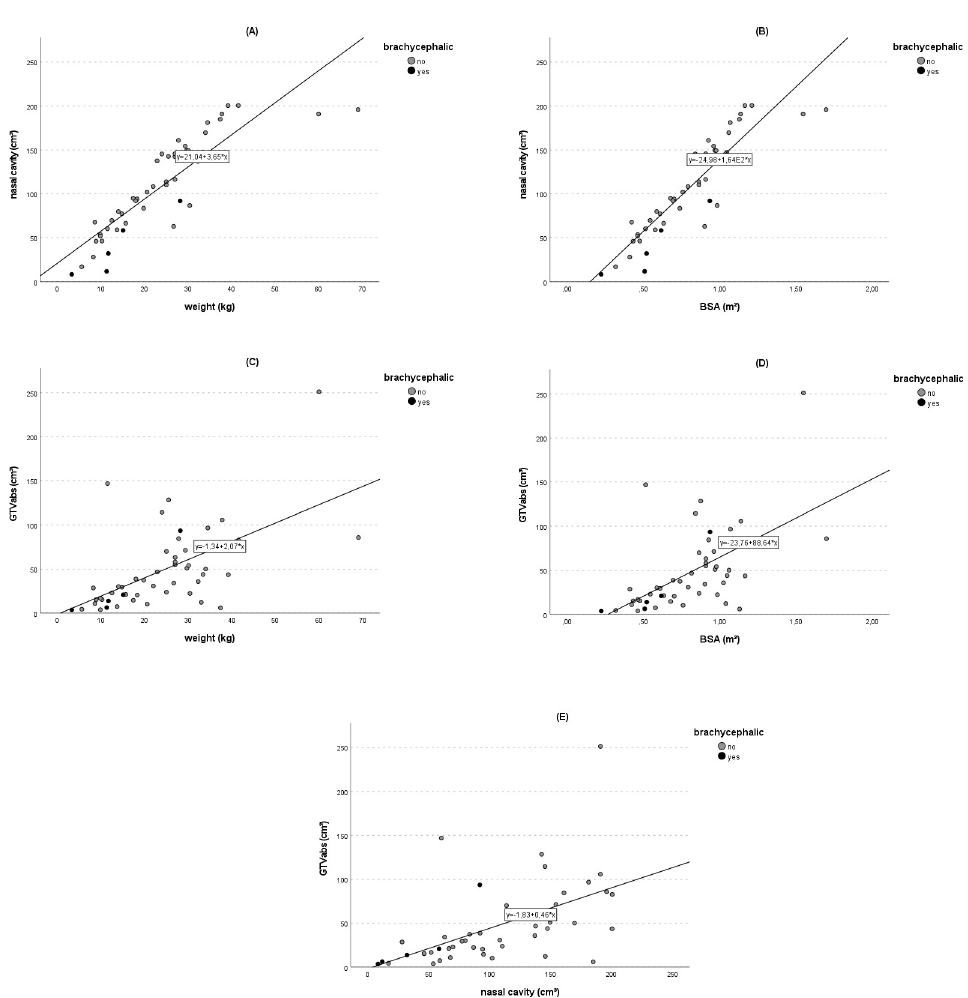
Fig 1. Correlation between nasal cavity, tumor volume and dogs’ sizes. (A) The size of the nasal cavity (cm 3 ) was positively correlated with weight ( r = 0.87; p < 0.001) and (B) BSA ( r = 0.90; p < 0.001) in all 49 dogs. (C-E) The absolute GTV (GTVabs) also correlated moderately with dogs’ weight, BSA, and with nasal cavity size (p < 0.001). The black dots depict the five dogs of brachycephalic